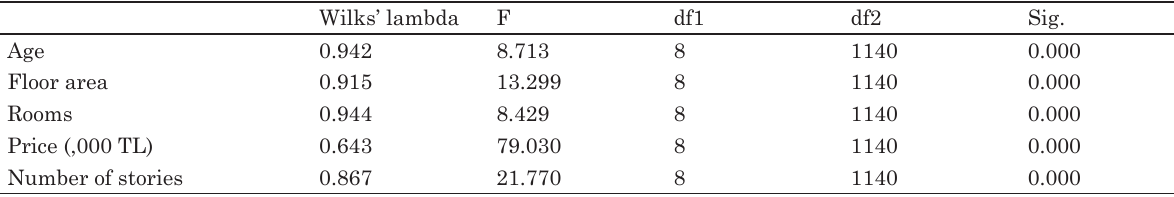
Table 5. Tests of equality of group